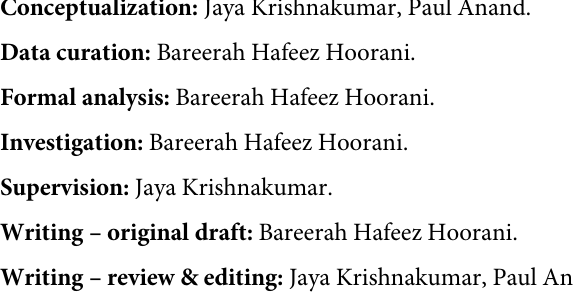
S12 Table. First difference estimation for resilience with shocks. S13 Table. First difference estimation for PPVT scores with shocks. S14 Table. Instrumental variable estimation for PPVT scores with